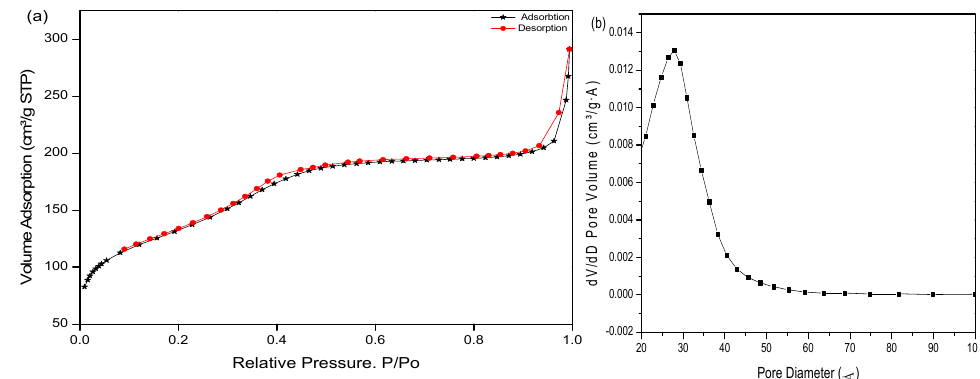
Figure 4. ( a ) Nitrogen adsorption–desorption isotherm plot of mSiO 2 @SPION and ( b ) pore size of mSiO 2 @SPION synthesized with a core/shell structure to be homogenized.